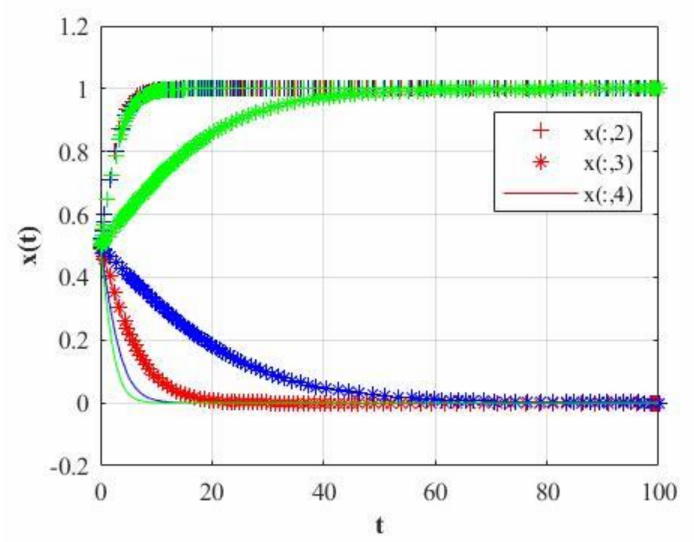
Figure 22. Change the parameter λ 1 and δ 3 and their values are (0.8, 0.2) (red curve), (0.5, 0.5) (blue curve), and (0.2, 0.8) (green curve) so as to take the value of the three-way strategy evolution diagram. (4) Both anchors and consumers hold social preferences, and δ 3 (cid:54) = 0, δ 4 (cid:54) =